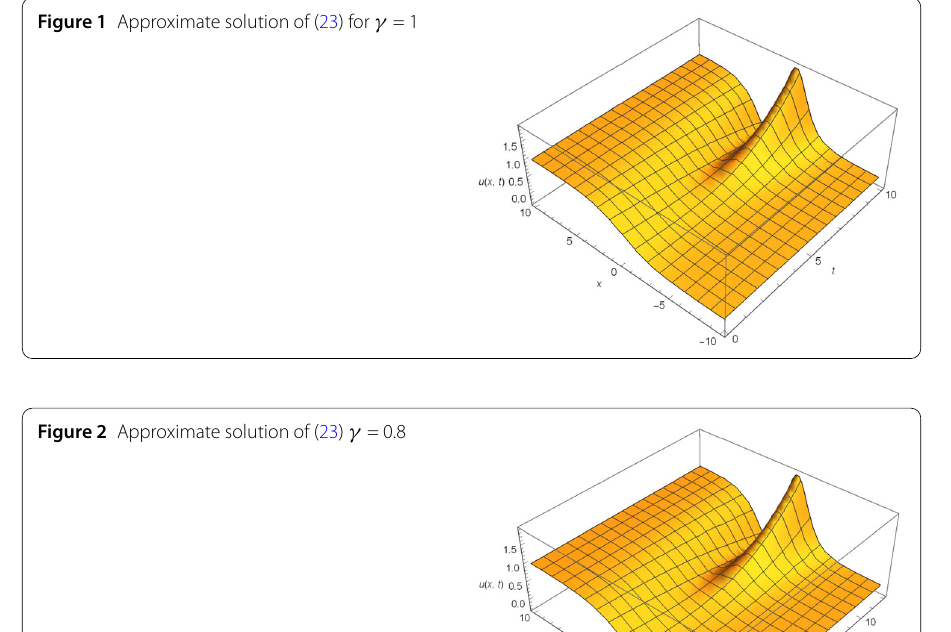
Figure 3 Approximate solution of (26) for γ = 1, y = x